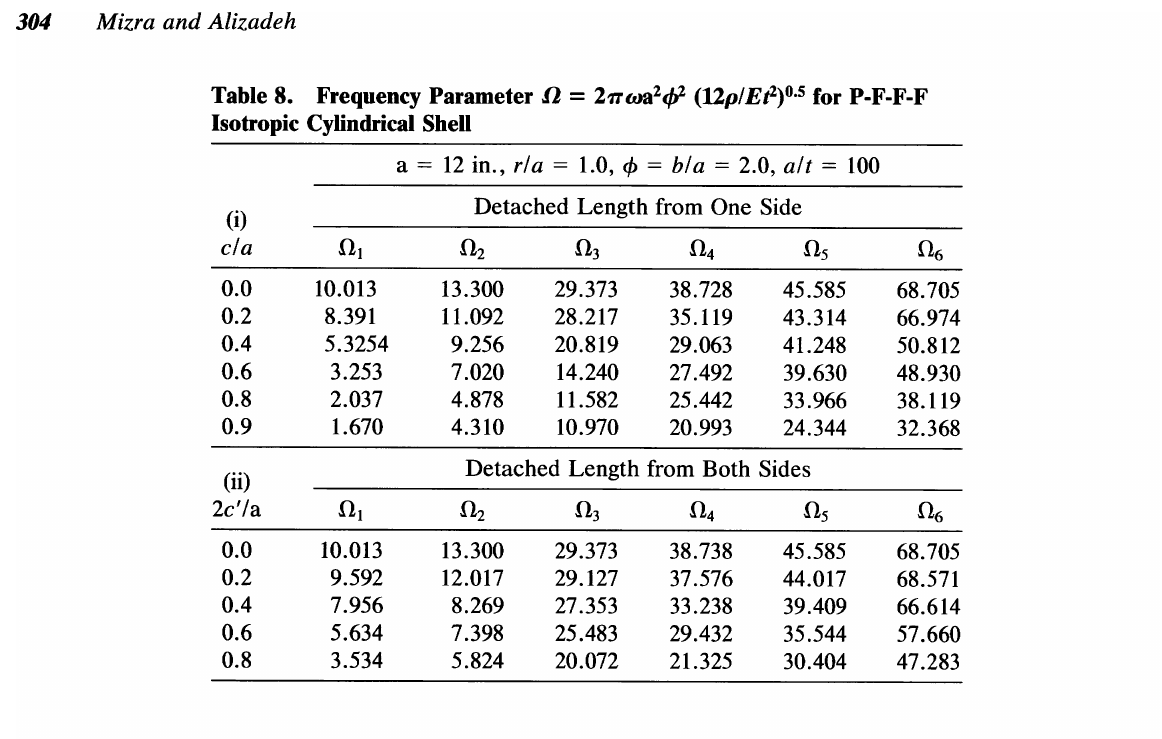
Table 8. Frequency Parameter n Isotropic Cy6ndrical Shell